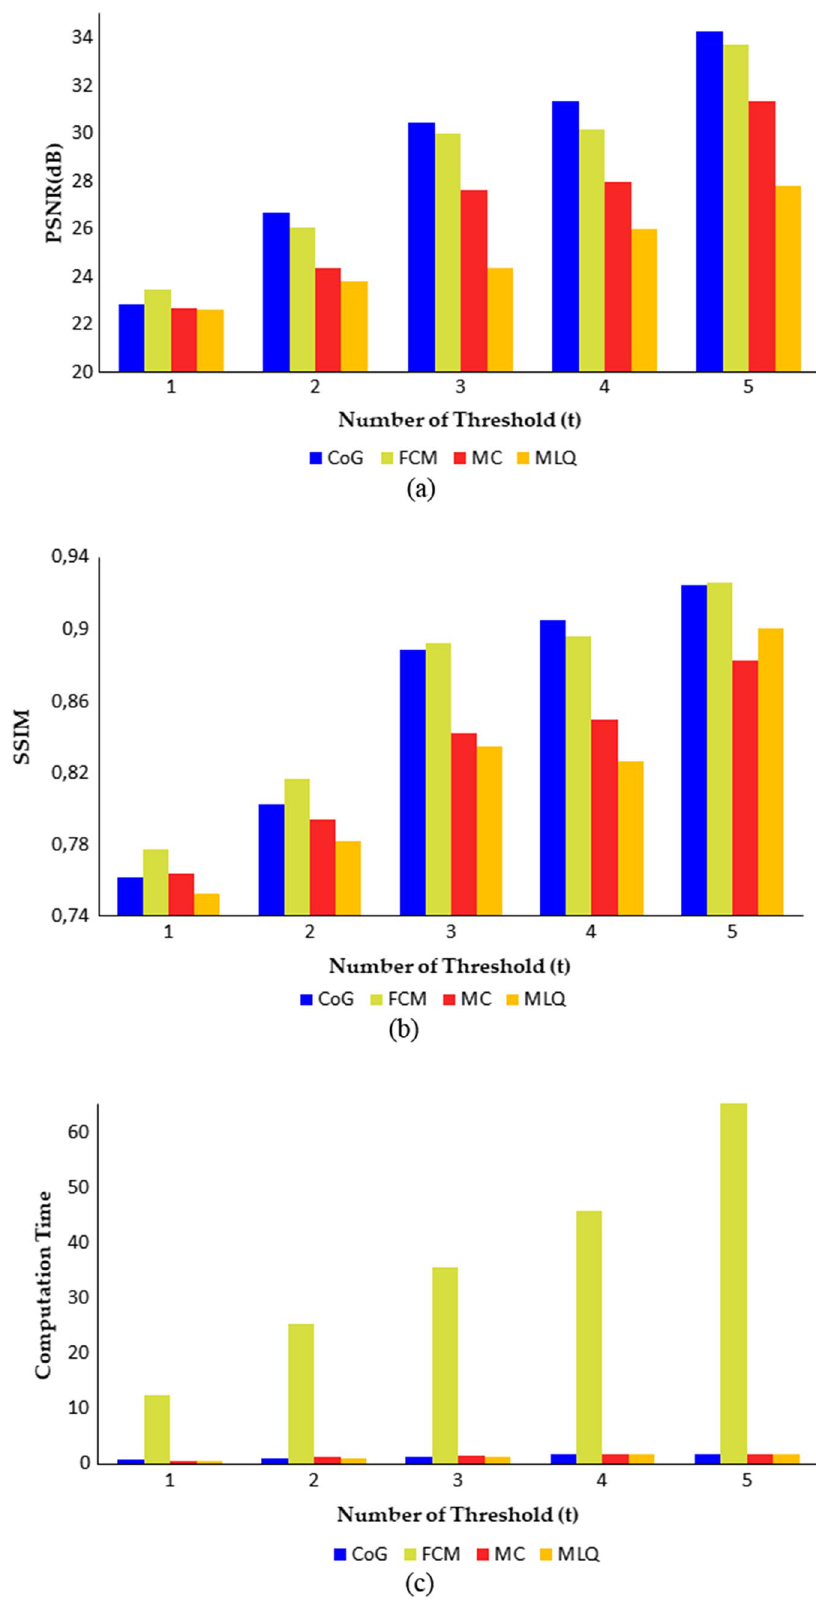
Fig. 7 Average performance of algorithms with different numbers of color on BSDS images: a PSNR, b SSIM, and c computation